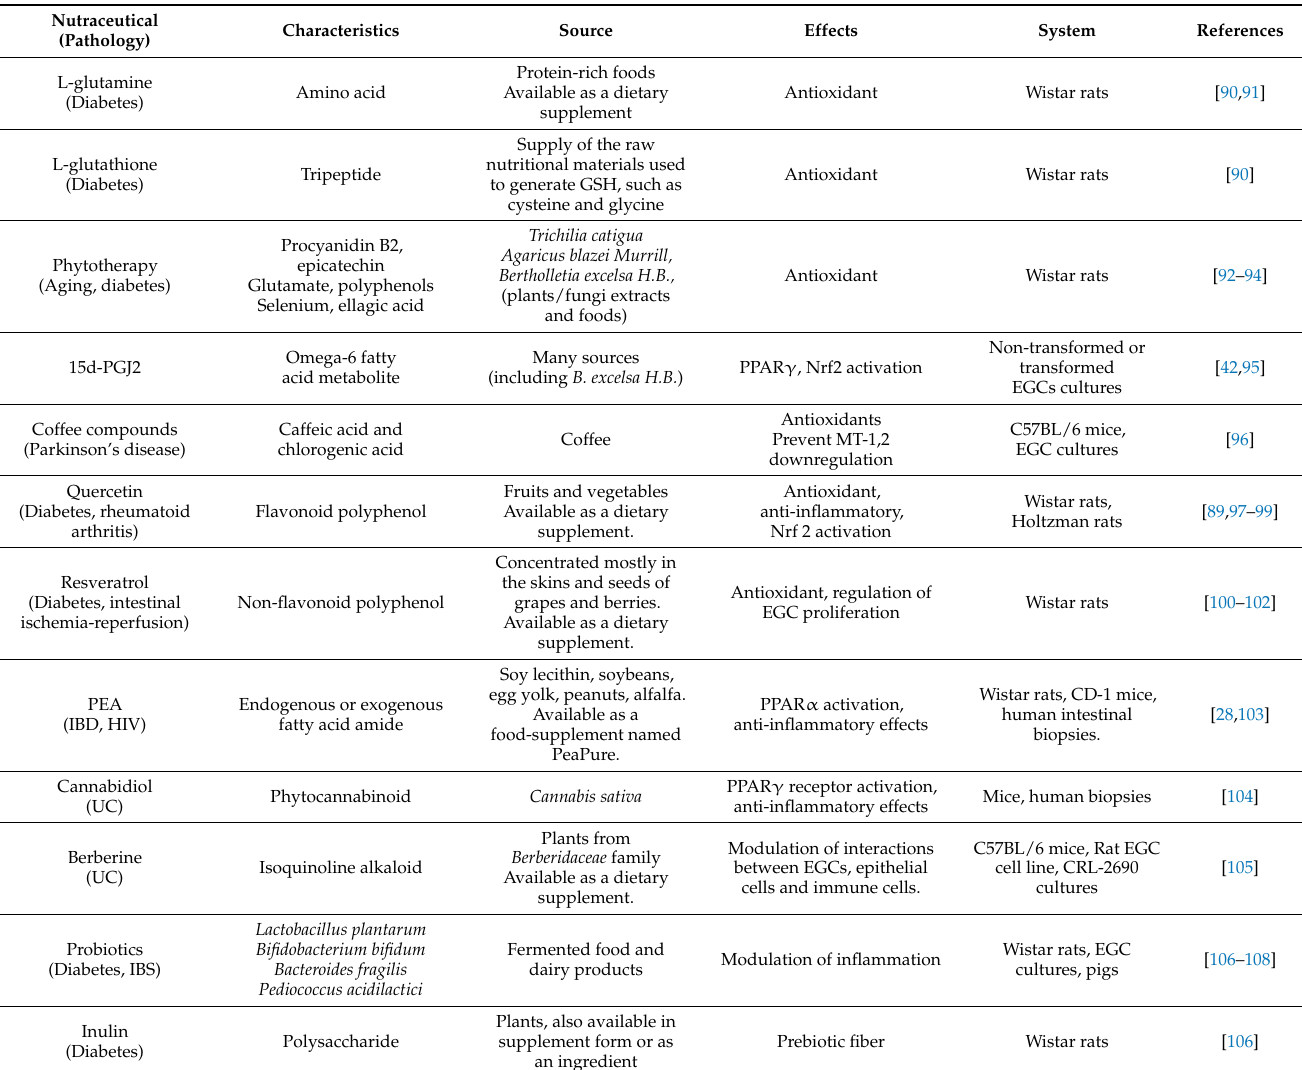
Table 3. Effects of nutraceuticals on enteric glial